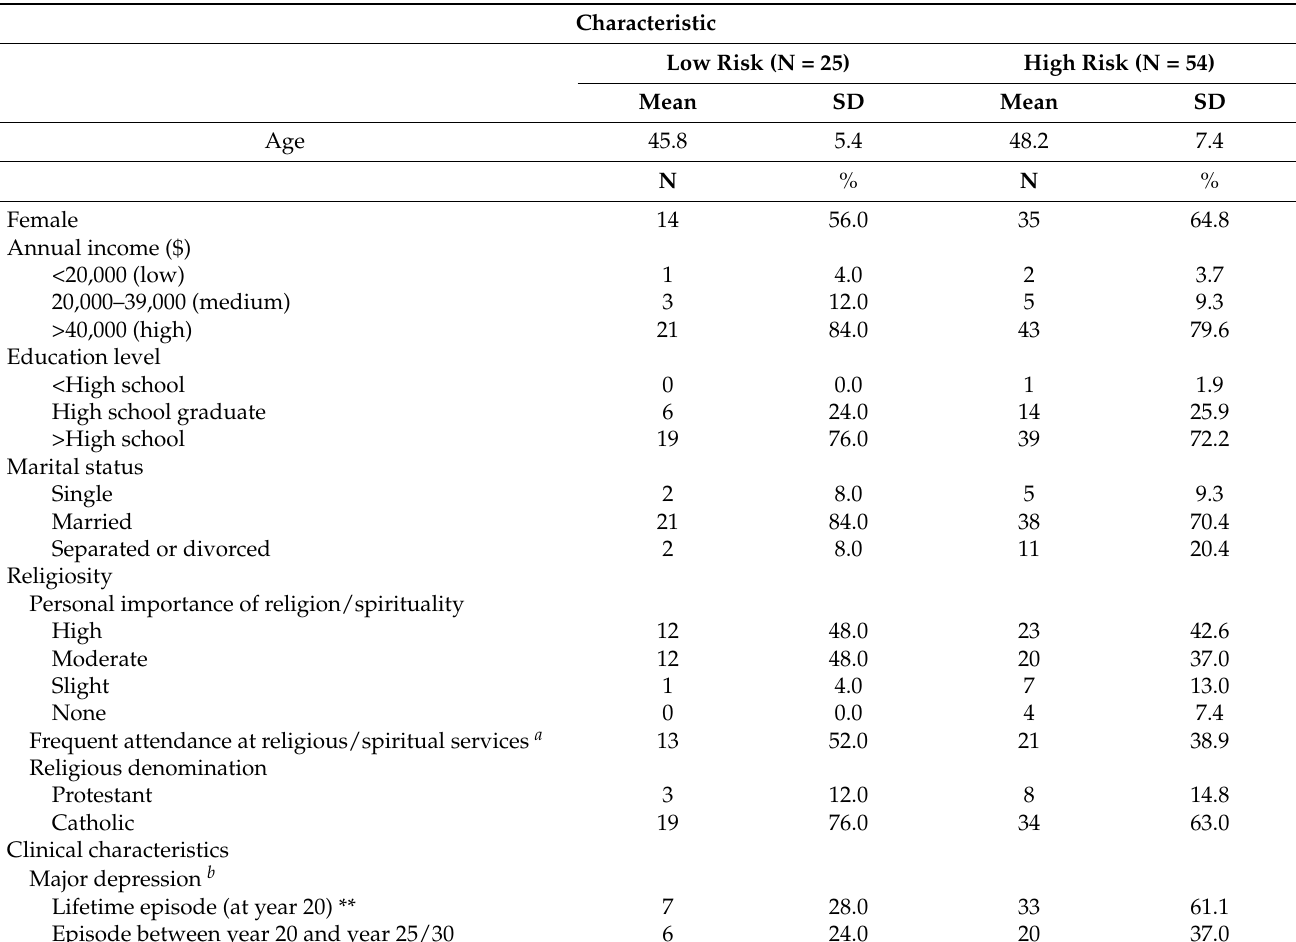
Table 1. Demographic, religiosity, and clinical characteristics of 79 adult offspring of depressed and nondepressed parents at 25/30-year follow-up in a 30-year study.